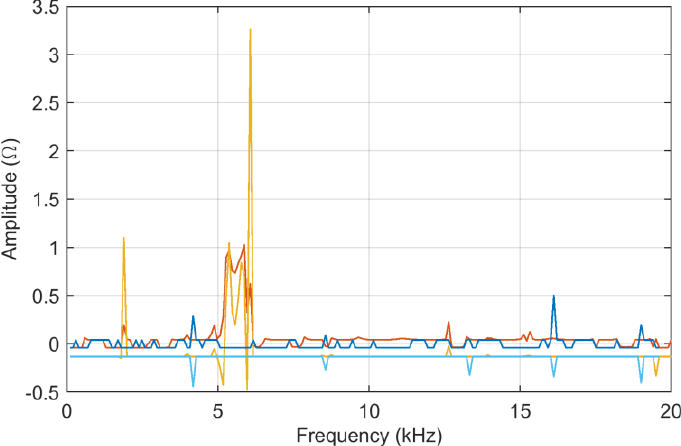
Figure 7. Z (45.0 km) and Z (45.5 km) input data in logarithmic scale: skewness in dark color and kurtosis (offset around 0) in light color for ADM i (orange sk and yellow ku ) and FDM i (blue sk and light blue ku ).